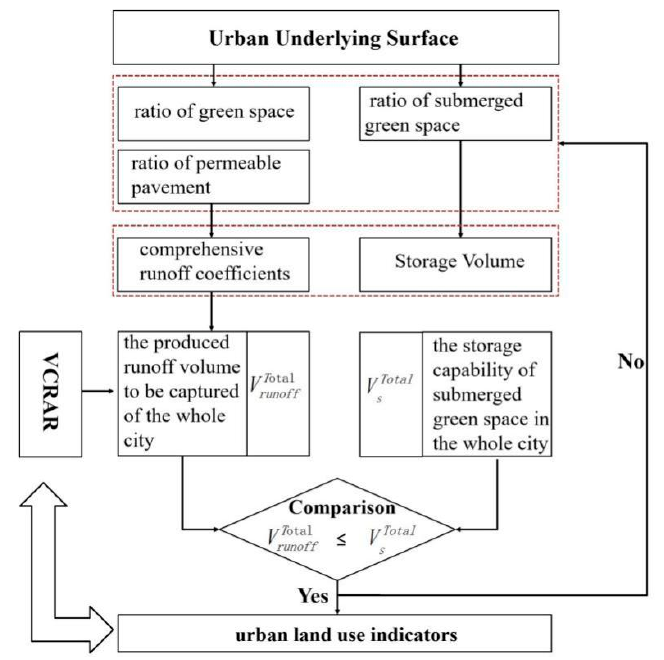
Figure 4. The indicator conversion model and calculation process from VCRAR to urban land indi- cators.